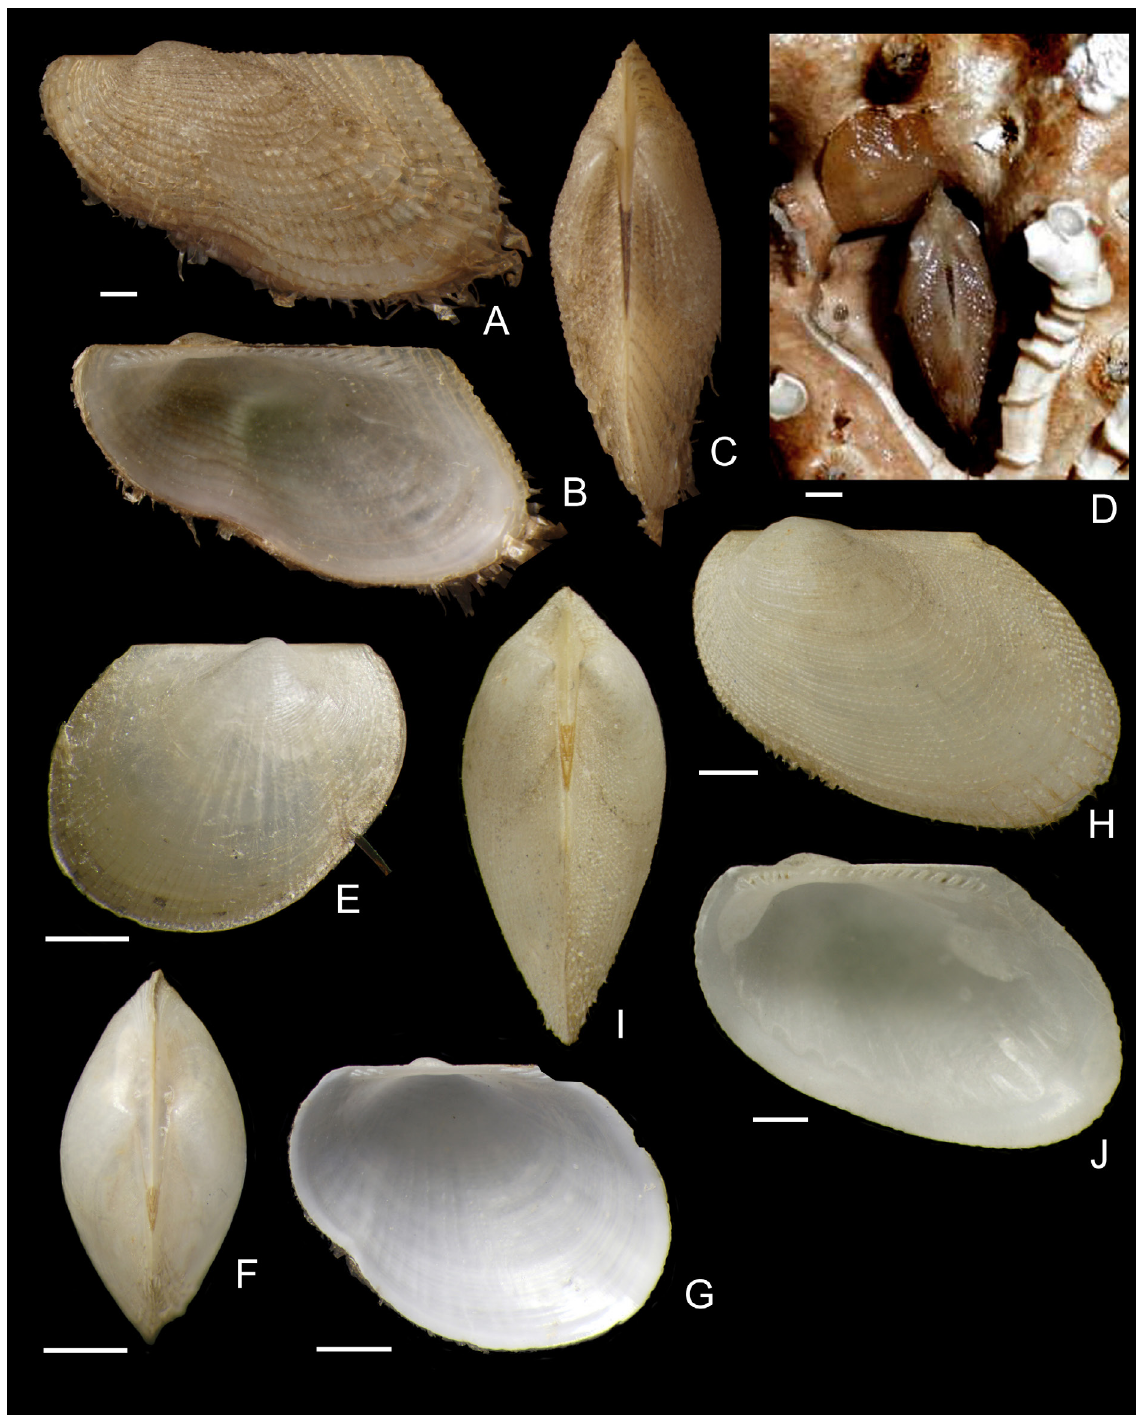
Fig. 33. Arcidae. A–C . Asperarca nodulosa (Müller, 1776), BANGAL 0711, DR14, 1130 m, 13.3 mm. D . A. nodulosa among dead coral branches, BANGAL 0711, GOC6, 903 m. E–G. Bathyarca pectunculoides (Scacchi, 1835), SEAMOUNT 1, DW108, 1110–1125 m, 4.3 mm, 4.4 mm and 5.1 mm. H–J . Bathyarca philippiana (Nyst, 1848), SEAMOUNT 1, DW111, 675–685 m, 7.2 and 7.9 mm. Scale bars = 1